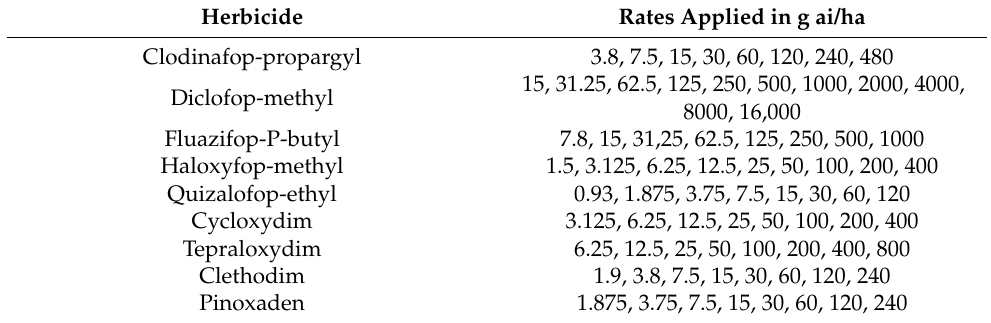
Table 1. ACCase-inhibiting herbicides and rates employed in the whole plant dose–response study. Herbicide Rates Applied in g